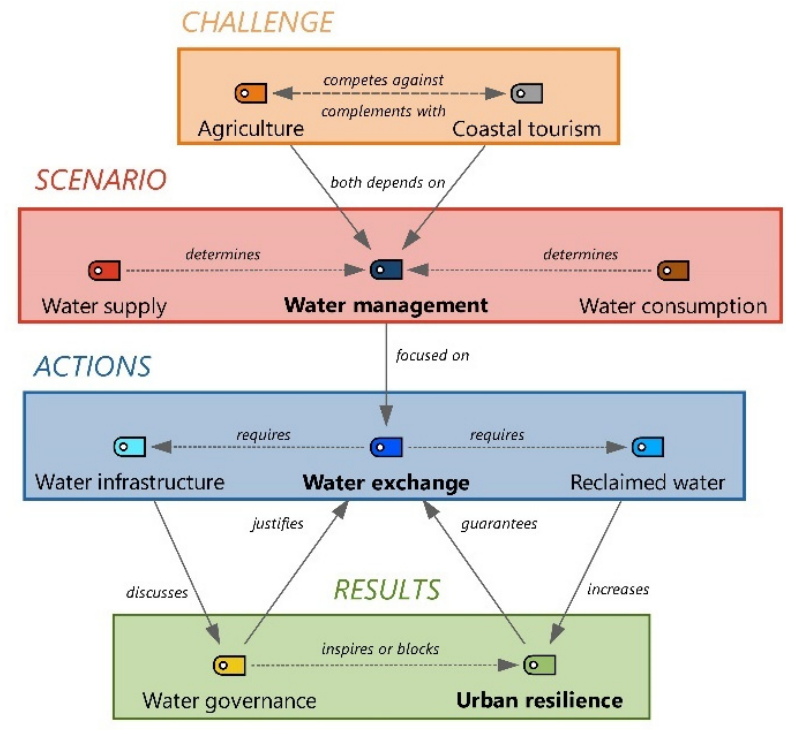
Figure 3. Coding map. Source: own elaboration.